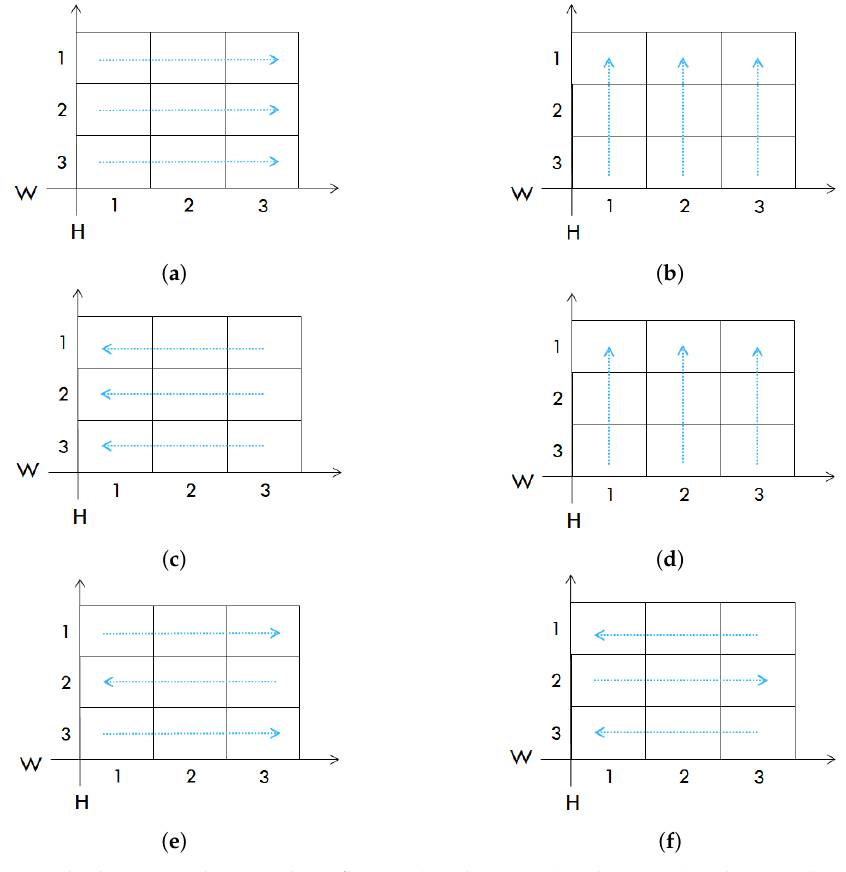
Figure 4. Yard relocation rules’ searching flows. ( a ) Rule Rr 1 . ( b ) Rule Rr 2 . ( c ) Rule Rr 3 . ( d ) Rule Rr 4 . ( e ) Rule Rr 5 . ( f ) Rule Rr 6 .